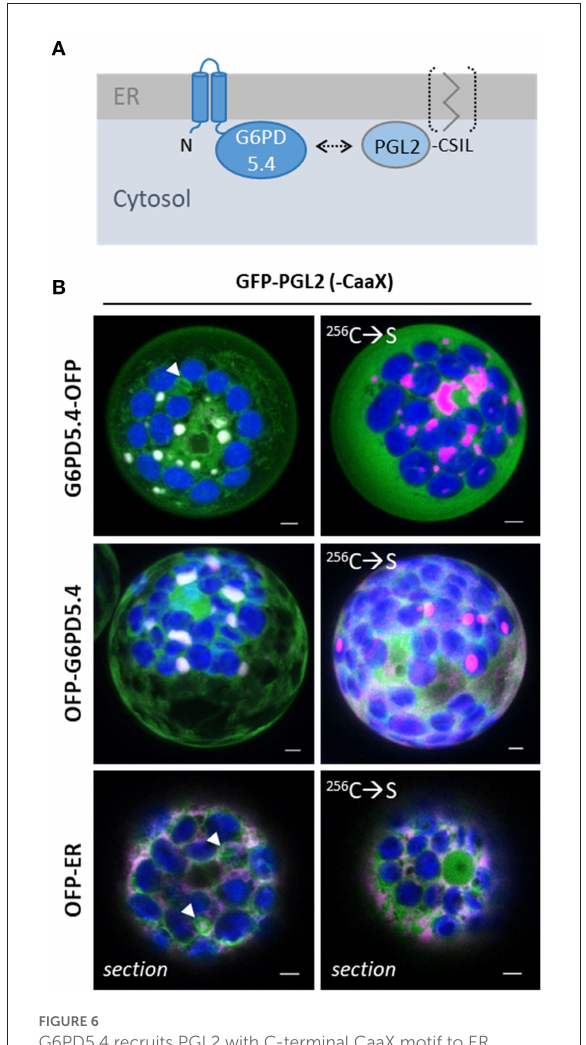
FIGURE6 G6PD5.4 recruits PGL2 with C-terminal CaaX motif to ER subdomains. (A) Scheme depicting that G6PD and PGL